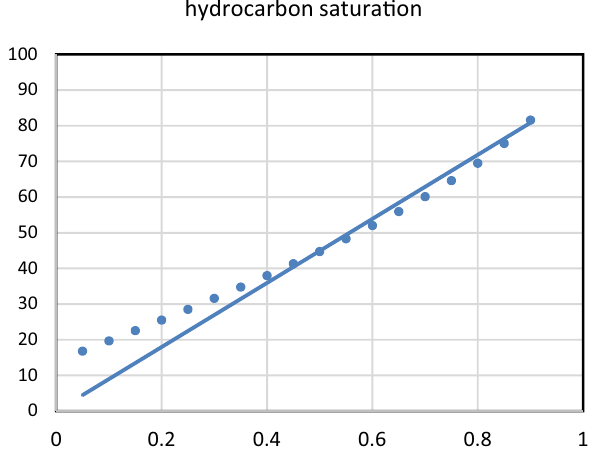
Fig. 33 Hydrocarbon saturation from sonic